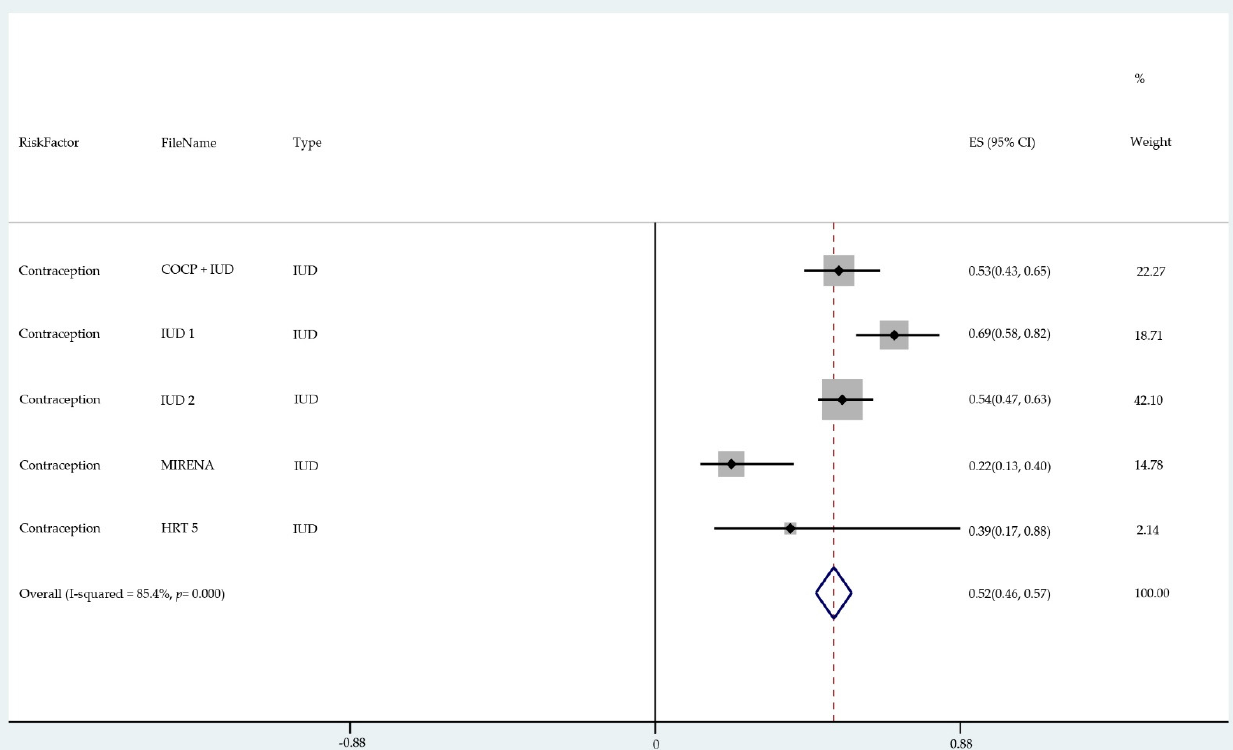
Figure 7. Forest plot to show risk of contraception (IUD).